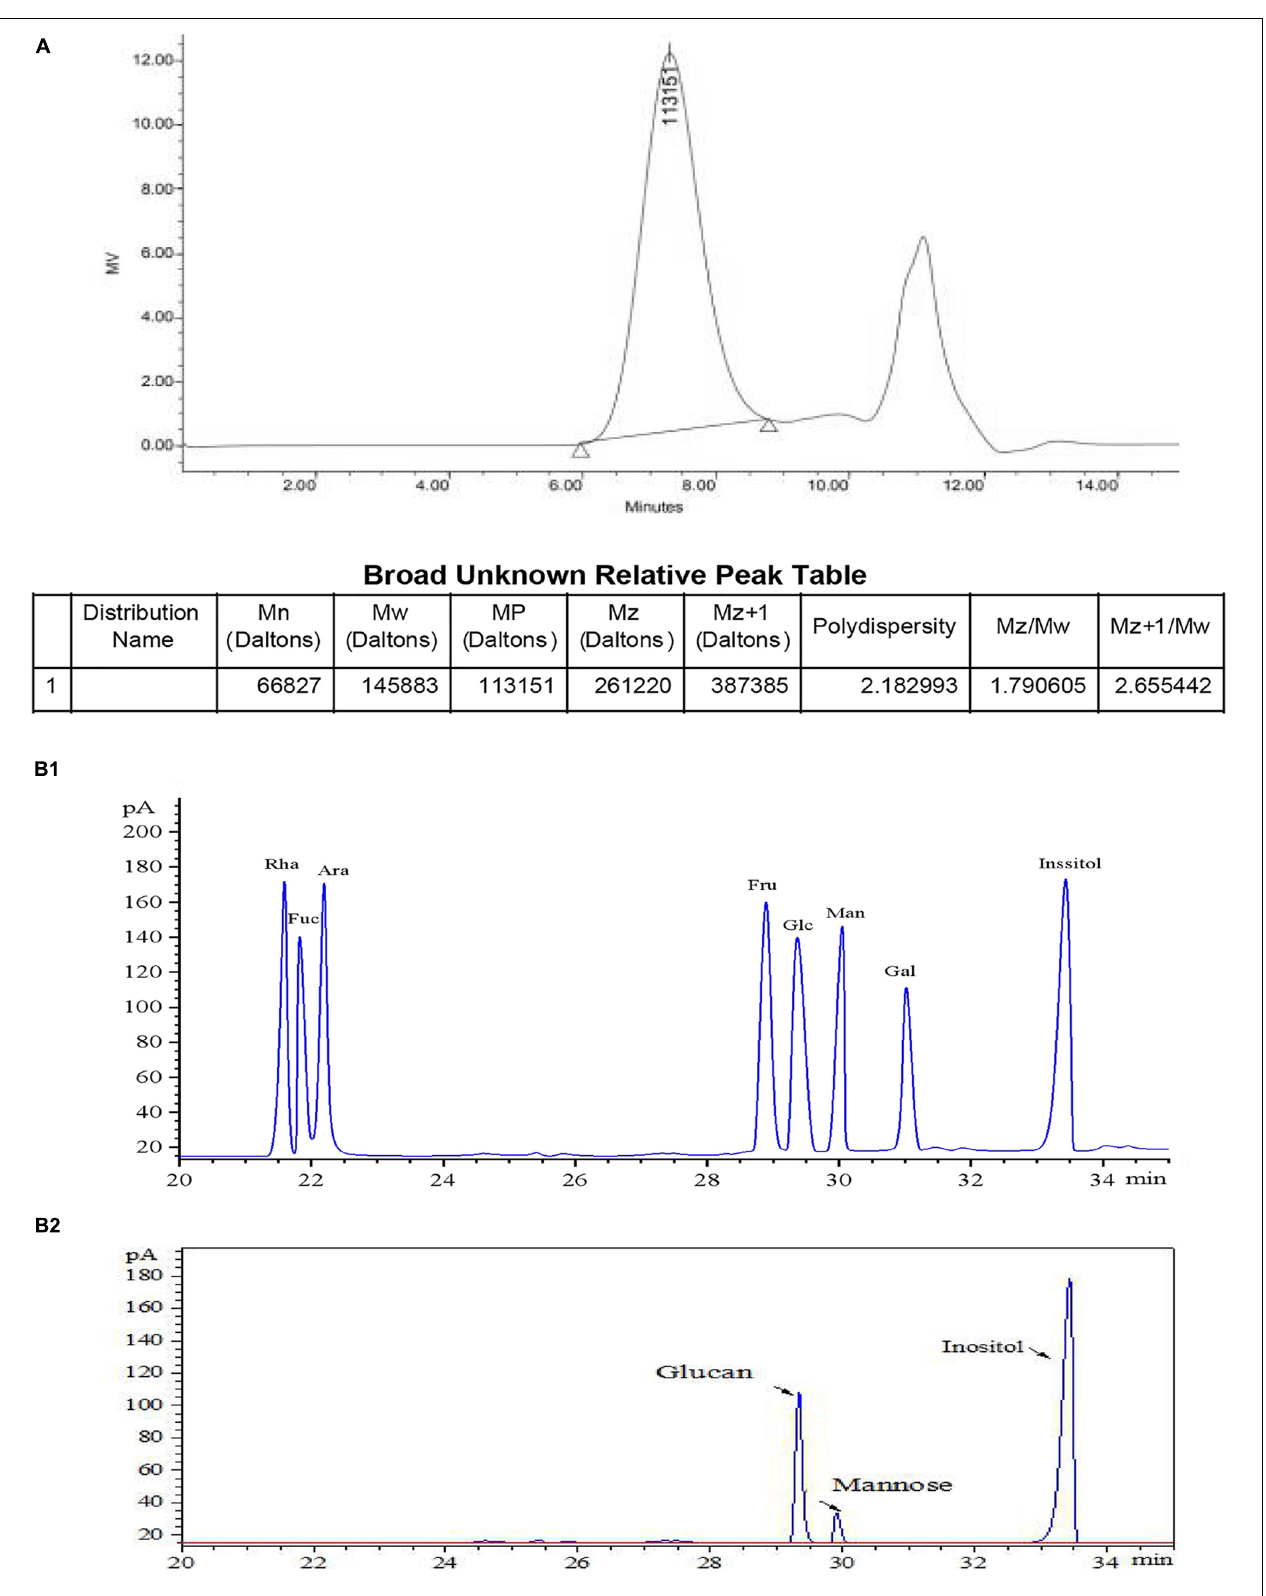
FIGURE 2 | Determination of molecular mass of EPS-S-2 (A) , standard monosaccharide by GC (B1) , and monosaccharide composition of EPS-8-2 by GC (B2) .